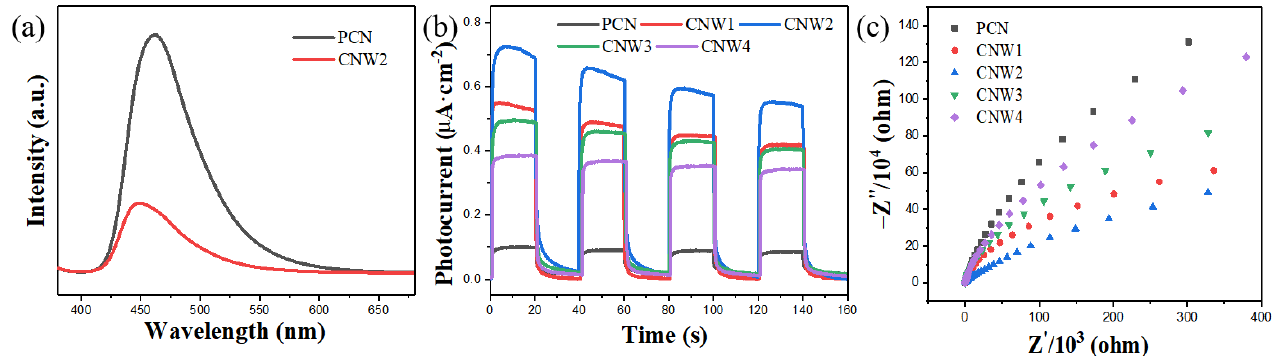
Figure 6. ( a ) PL spectra of PCN and CNW2, ( b ) the transient photocurrent response curves, and ( c ) the electrochemical impedance spectra of PCN, CNW1, CNW2, CNW3, and CNW4.